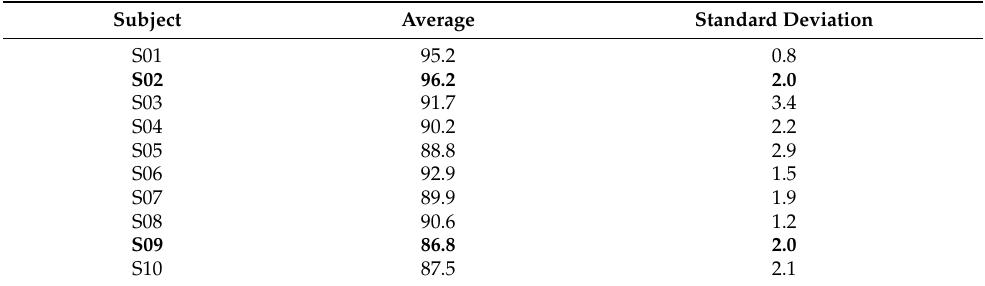
Table 4. Average classification accuracy (expressed in percentage) for the inertial model trained to classify the performance of the AR models of the ten subjects that participated within the data collections of InSync dataset.